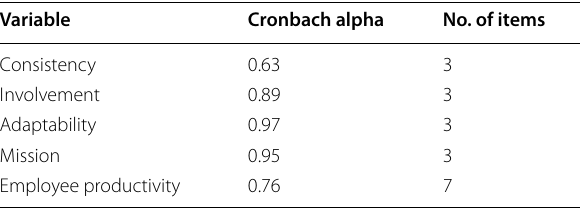
Table 4 Reliability test results